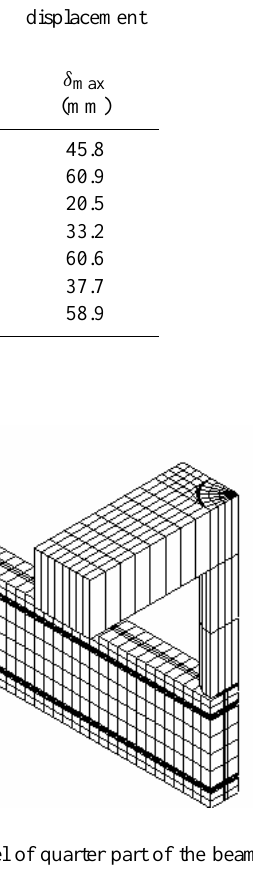
concrete be Fig. 15. Details of reinforced Fig. 15. Details of reinforced concrete beams.